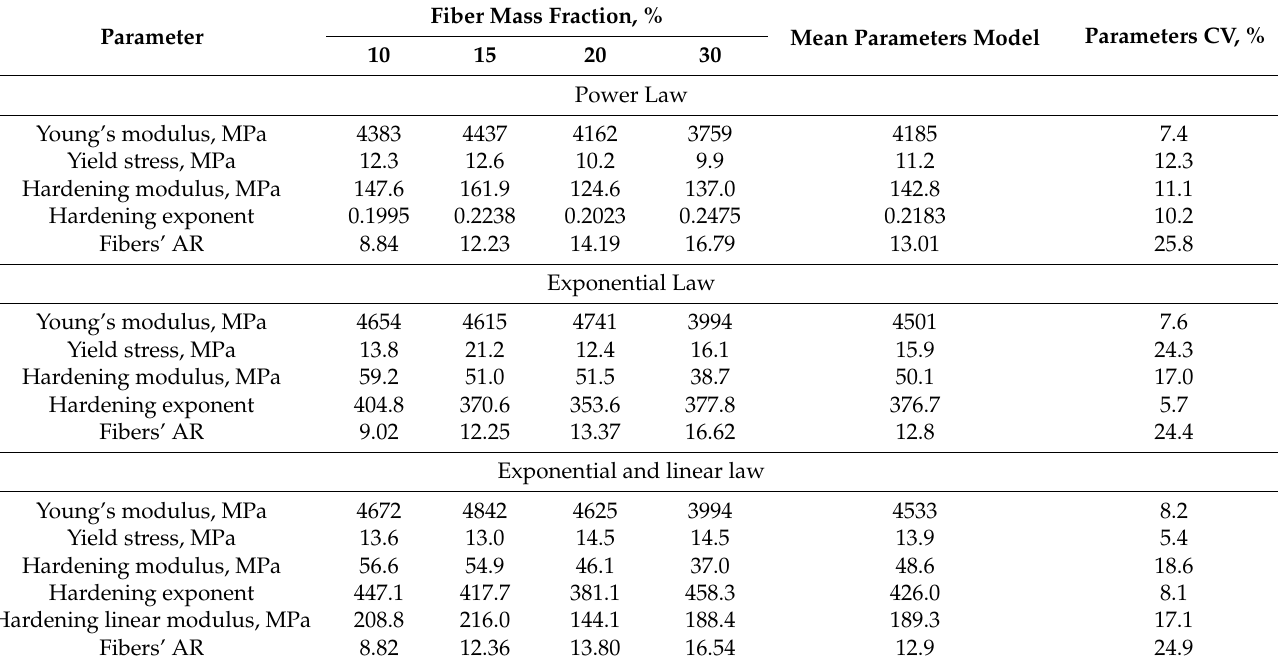
Table 4. Calibration of all parameters of the matrix elastoplasticity model and fiber aspect ratio.